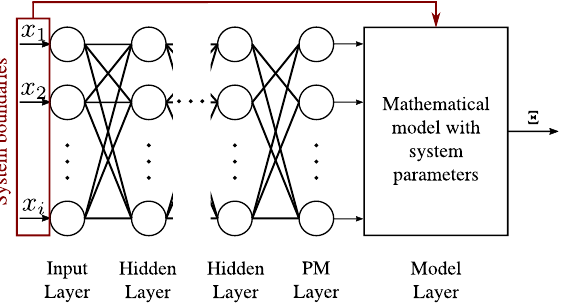
Figure 5. Architecture schema of the IMANN used in benchmark